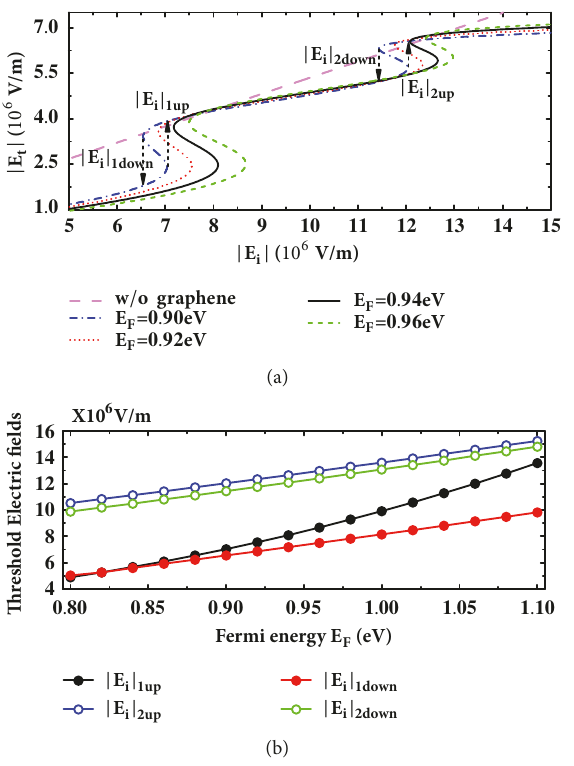
Figure 2: (a) Schematicdiagram of the transmitted electricfield as a function of the incident electric field for different Fermi energies 𝐸 𝐹 of thegraphene.(b)Schematicdiagram of theswitch-upand switch- up threshold electric field as a function of 𝐸 𝐹 .